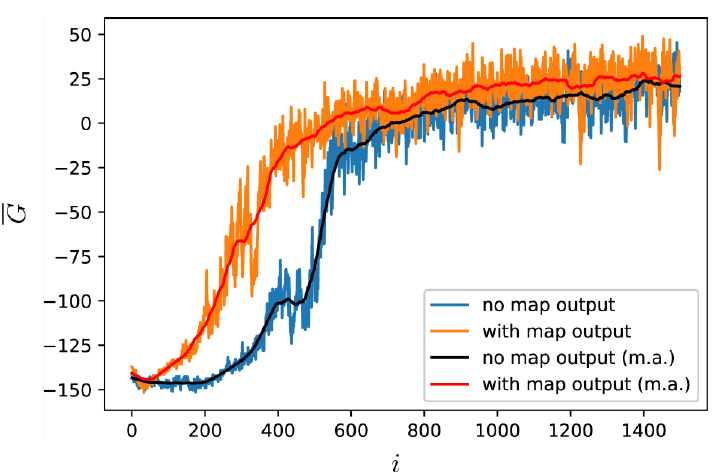
Figure 13. A3C average cumulative reward with and without “map output” for the first 1500 iterations. Filtered outputs are obtained using a moving average with a rolling window w = 100.